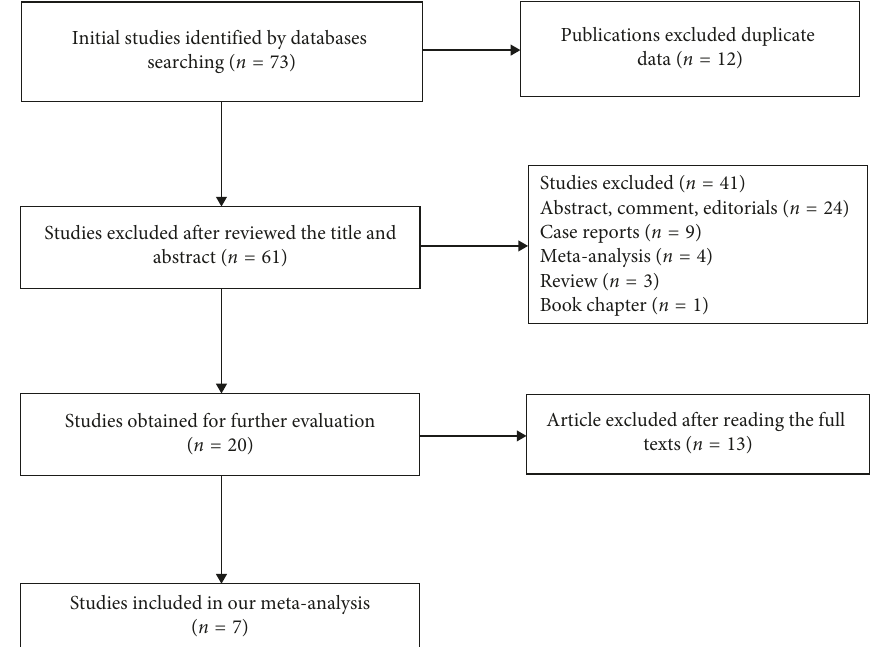
Figure 1: Flowchart used to include studies in the present